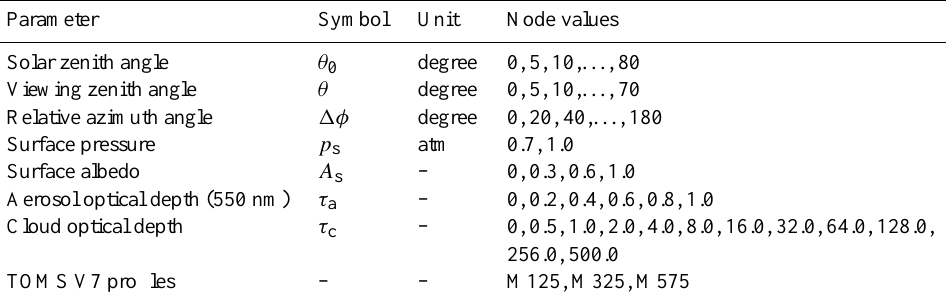
Table 2. Node points of the cloud optical depth look-up table. A subset of the TOMS V7 ozone profile climatology is used together with the associated temperature profiles. M125, M325 and M575 refer to the middle latitude profiles for total ozone columns of 125, 325 and 575DU,